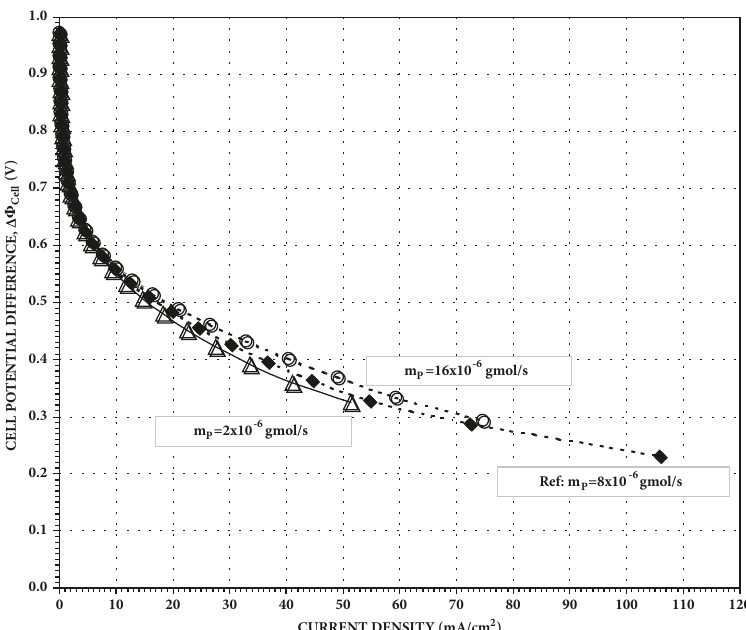
Figure 11: The effect of the propane inlet molar flow rate, m (gmol/s), on the polarization curve for a direct propane fuel cell (DPFC) model P at 150 ∘ C and 1 atm. The values of m (gmol/s) for the above three cases were represented by the following symbols: (i) open circles: 16x10 −6 P gmol/s, (ii) solid diamonds: 8x10 −6 gmol/s (reference case), and (iii) open triangles: 2x10 −6 gmol/s. All the other parameters were the same as the reference case mentioned in Table 1.